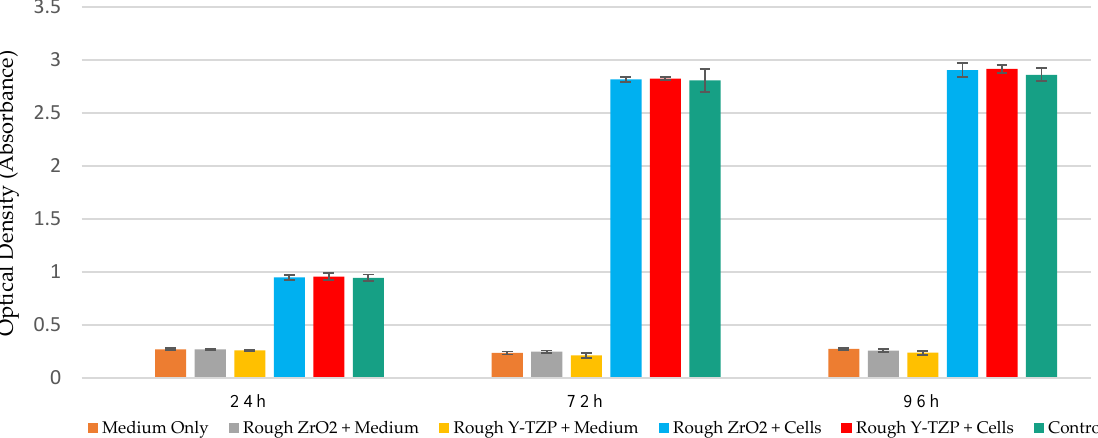
Figure 4. Metabolic activity monitoring (WST1 assay) of Saos-2 cells exposed to rough surfaces (Ra = 1 µm) of ZrO2 and Y-TZP for 24 h, 72 h, and 96 h (N = 4). ANOVA: Analysis of one-factor variances (ZrO2 vs. Y-TZP vs. controls). Not Significant at 24 h, 48 h, and 96 h.